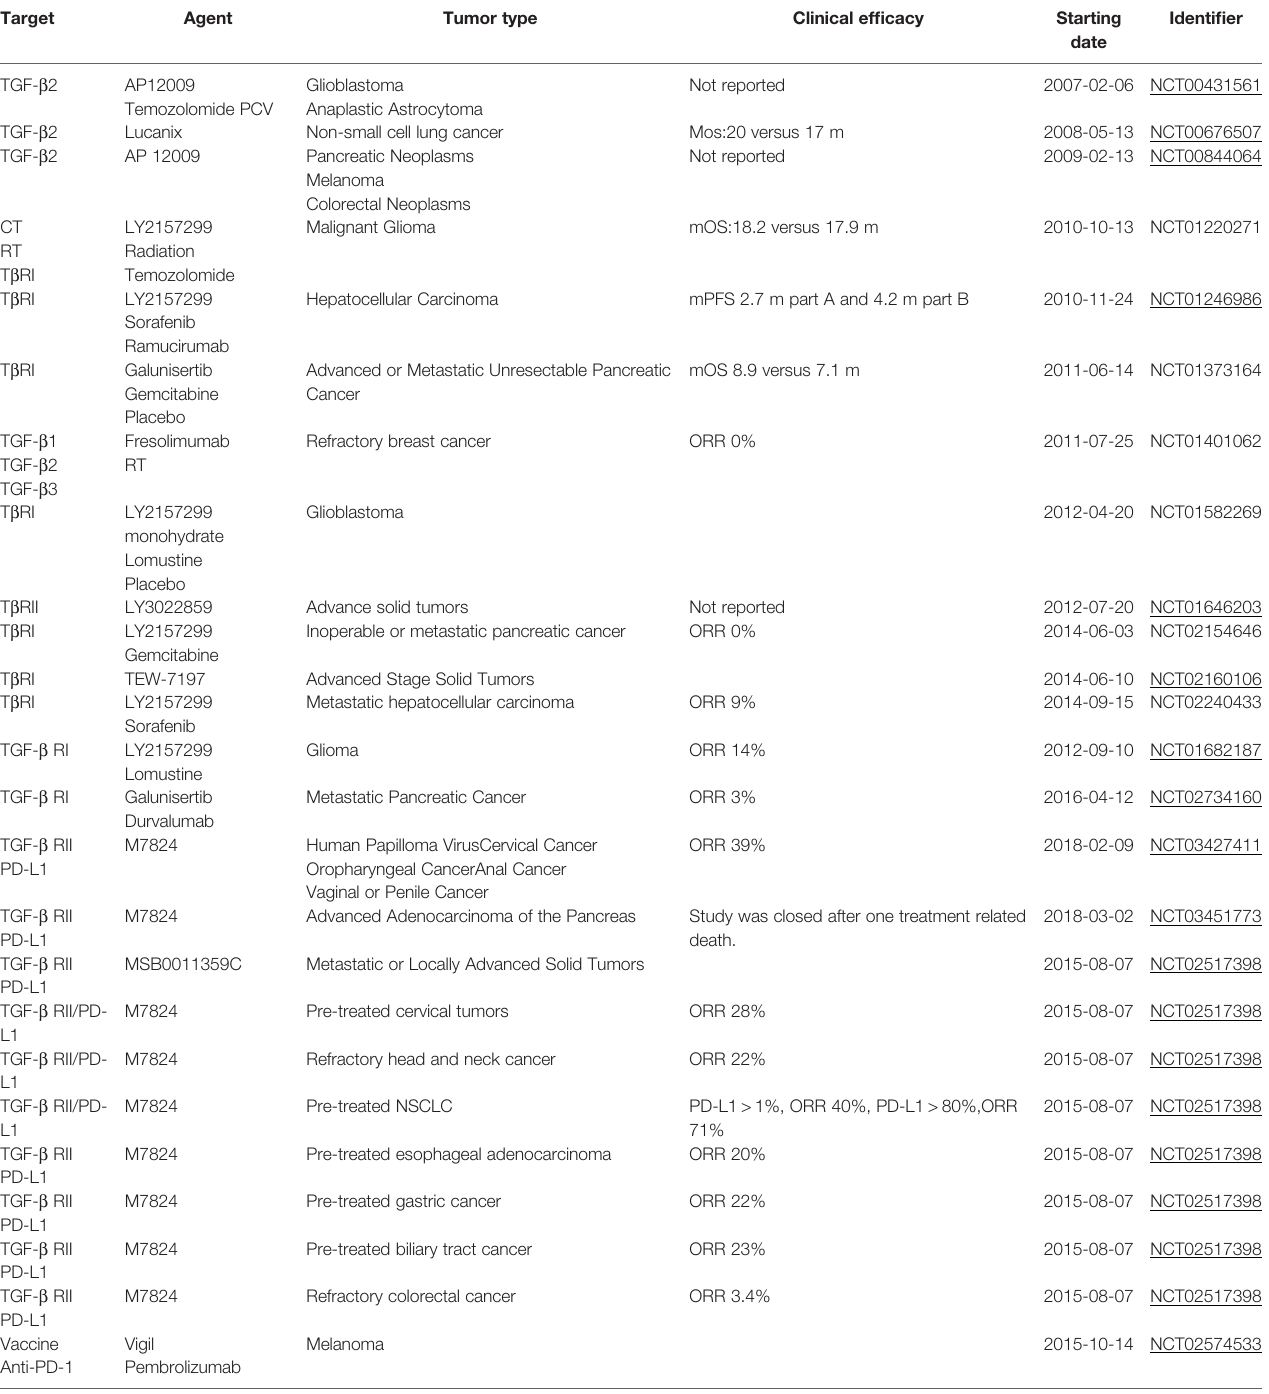
TABLE 1 | Completed clinical trials to evaluate TGF- b pathway